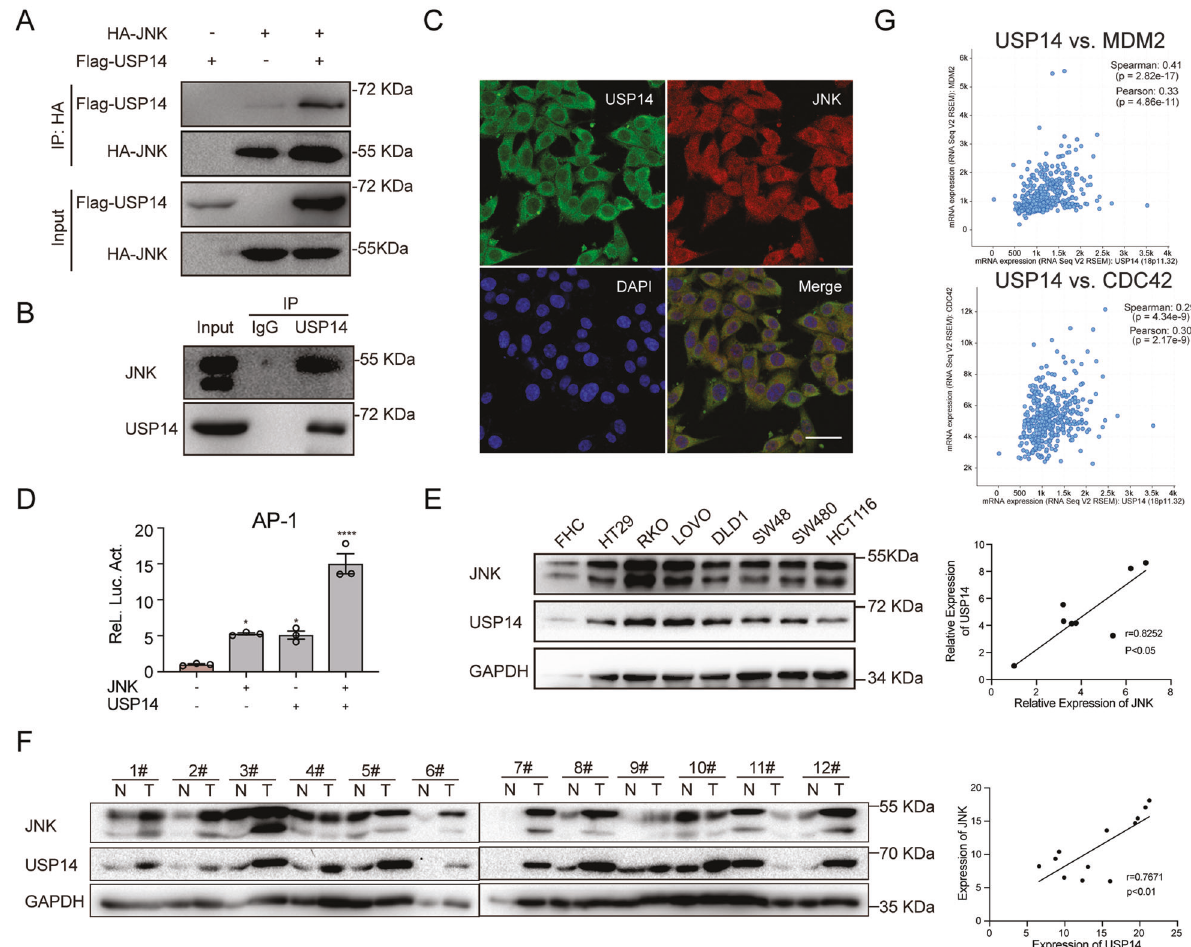
Fig. 4 USP14 associates with JNK. A , B The interaction of exogenous and endogenous USP14 and JNK were examined by immunoprecipitation in HEK293T or RKO cells, respectively. C The endogenous colocalization of USP14 (green) and JNK (red) in HEK293T cells was determined by immuno fl uorescence. DAPI was used to stain nuclei (blue). D The synergistic transactivation between USP14 (green) and JNK and AP-1 was assessed by luciferase assays ( n = 3). E USP14 is upregulated and positively correlates with JNK in various colorectal cancer cell lines. F USP14 is upregulated and positively correlates with JNK in colorectal cancer specimens. G The positive correlation between USP14 and JNK target genes (MDM2 and CDC42) from the cBioPortal online tool. Bar, 50 µm. N normal tissues. T tumor tissues. The data are presented as the means ± SEM. Statistical signi fi cance was analyzed by ANOVA. **** p <